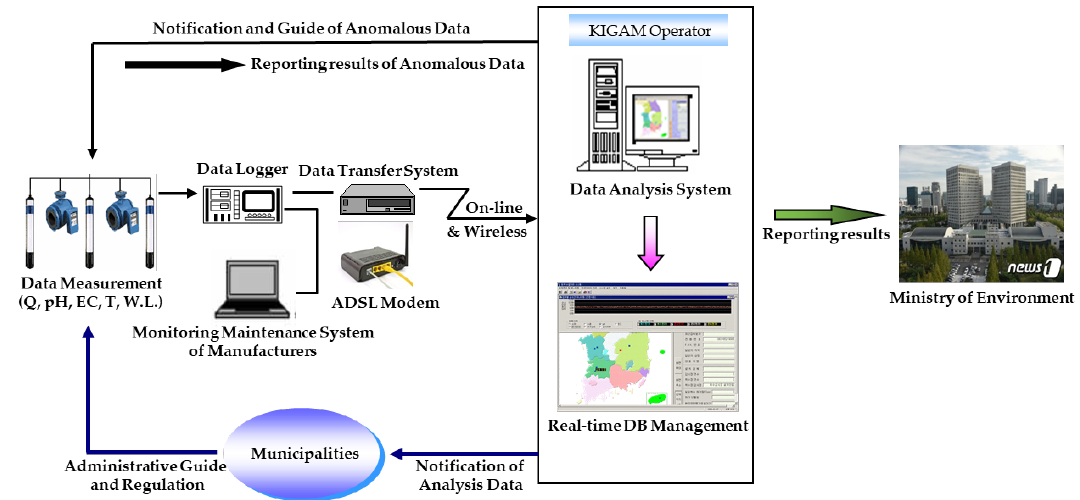
Figure 4. Management system of mineral water in South Korea.